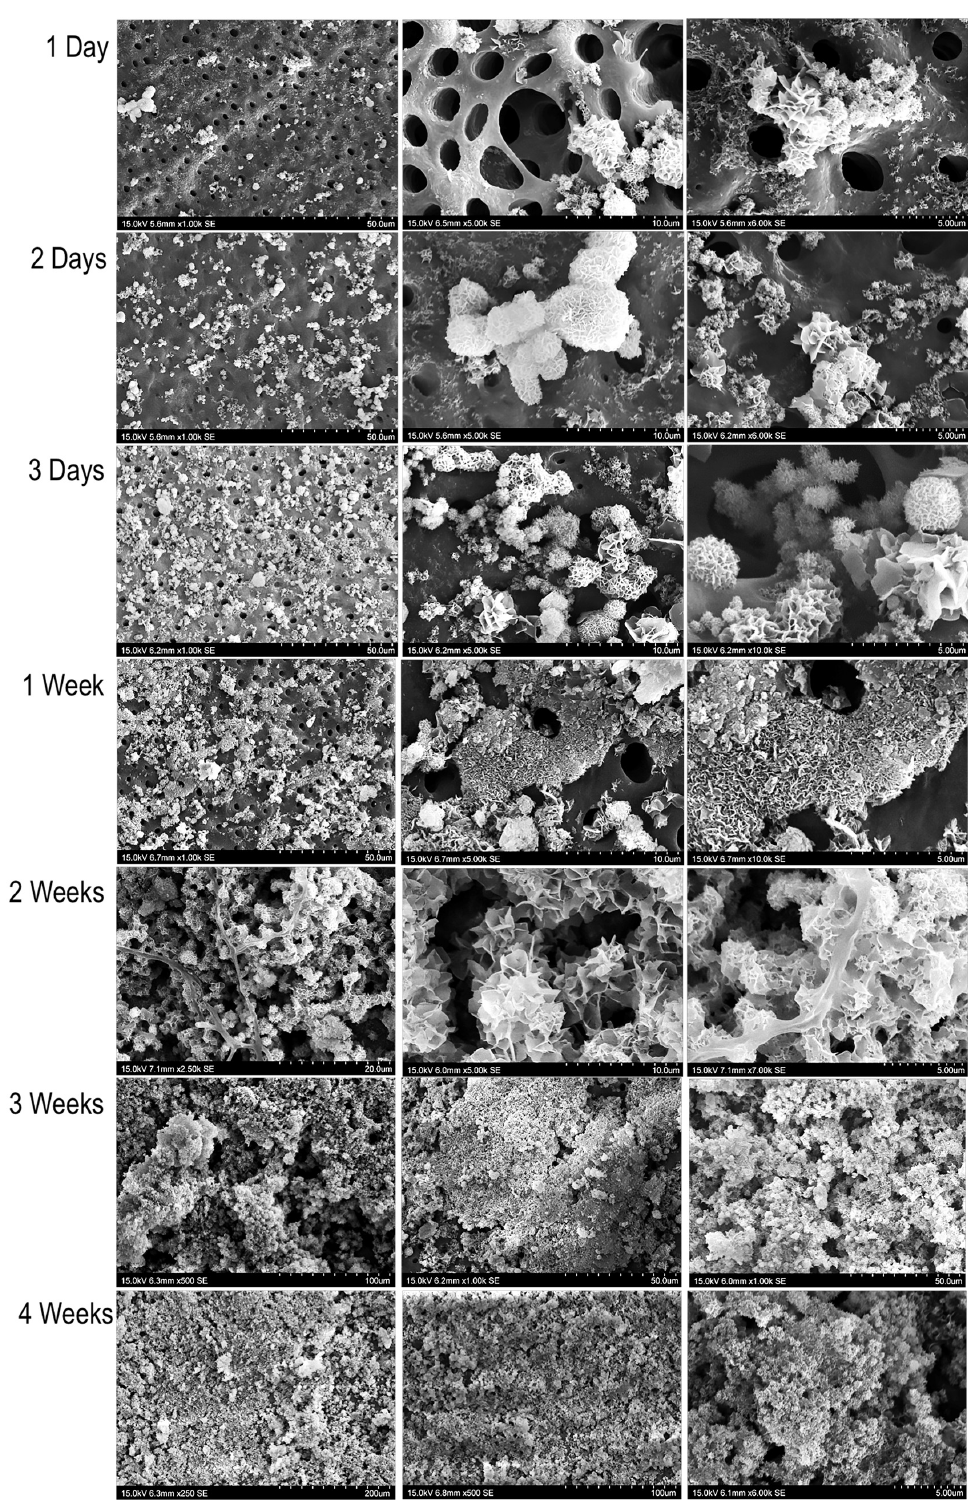
Figure 2. Evaluation of remineralisation by the biomimetic mineralisation model. Scanning electron microscopy (SEM) analysis of mineral deposition on demineralised dentin at the different periods of time. Three levels of magnification are shown for each timepoint. Mineral precipitation was observed mainly in the interior and surrounding the dentinal tubules. Over time, it was noted that our experimental model promoted remineralisation of the demineralised radicular dentin.